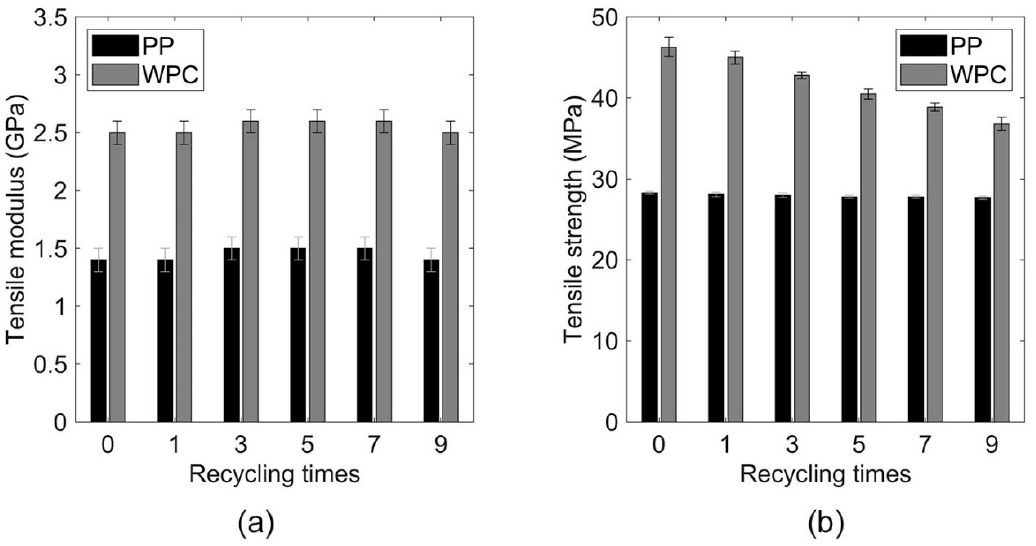
Figure 8. Tensile ( a ) and modulus ( b ) strength for PP and WPC samples before and after each recycling pass.